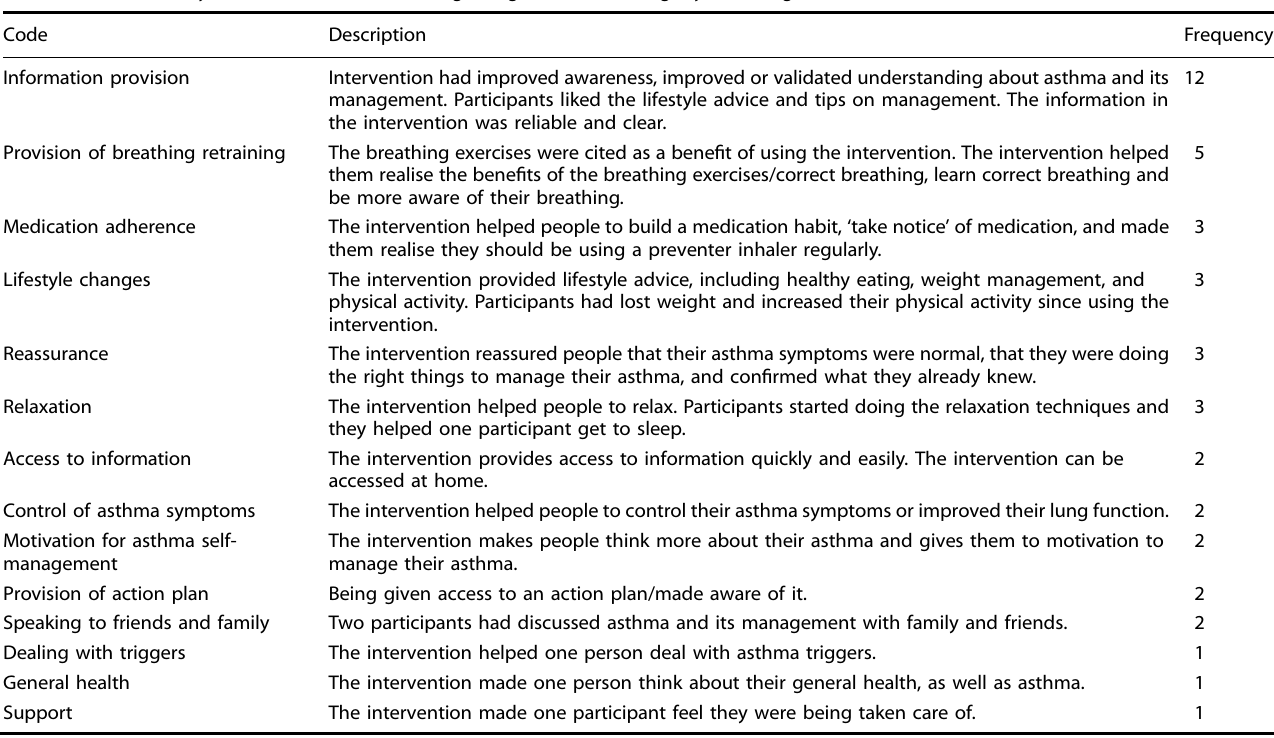
Table 3. Content analysis of free-text comments regarding bene fi ts of using My Breathing Matters ( n = 28). Code Description Frequency Information provision